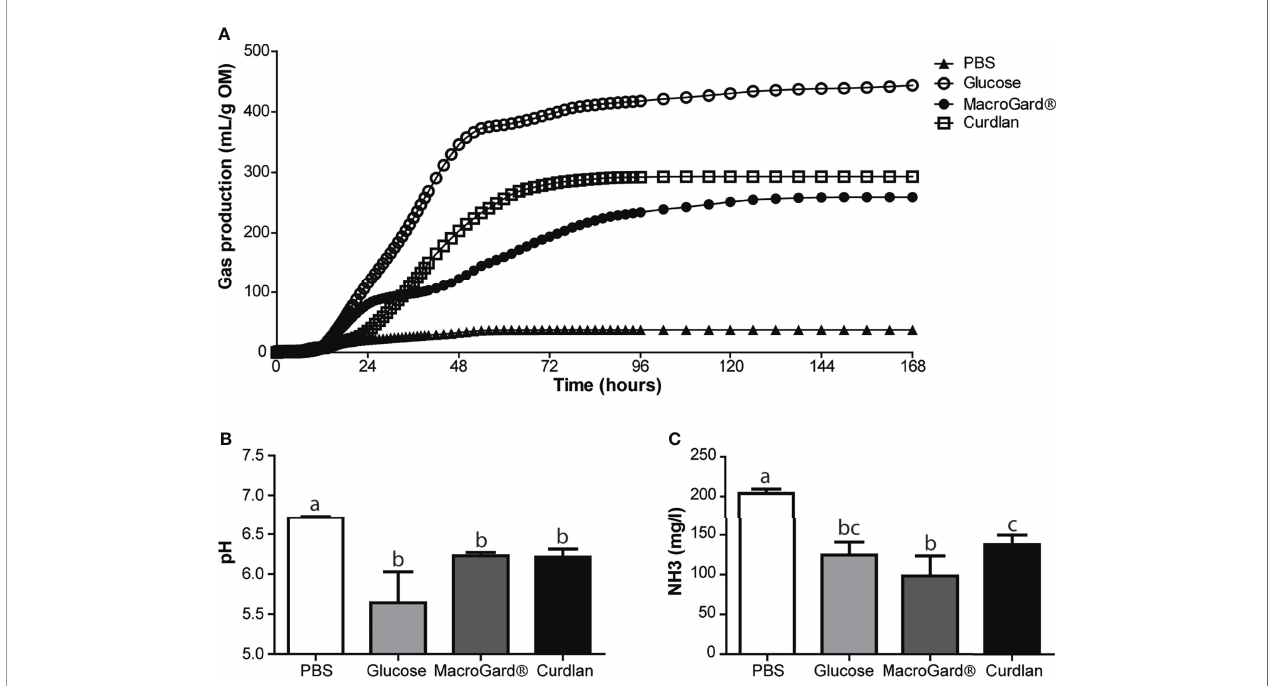
FIGURE 2 | Carp naive microbiota is capable of in vitro fermentation of different b -glucans. (A) Cumulative gas production over 168 h as a result of in vitro fermentation of PBS, glucose, MacroGard ® and curdlan by carp intestinal microbiota. Data shown as mean of n = 5 independent intestinal pools. Signi fi cant difference between cumulative gas production between MacroGard ® and curdlan from 44 – 86 h [two-way ANOVA followed by Bonferroni post hoc (not shown)]. (B) pH of fermentation fl uids after 168 h of in vitro fermentation (mean ± SD, n = 5). Signi fi cant differences between groups were assessed by Welch ’ s ANOVA followed by Games – Howell test. (C) Ammonia (NH 3 ) accumulation in fermentation fl uids after 168 h of in vitro fermentation (mean ± SD, n = 5). Signi fi cant differences between groups were assessed by one-way ANOVA followed by Tukey test. Groups with different letters are statistically different from one